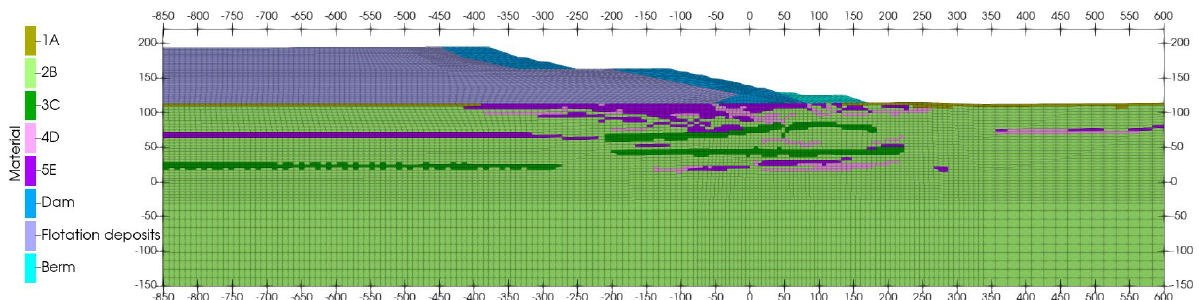
Figure 15 Geometry of model at the final step (250) of prediction